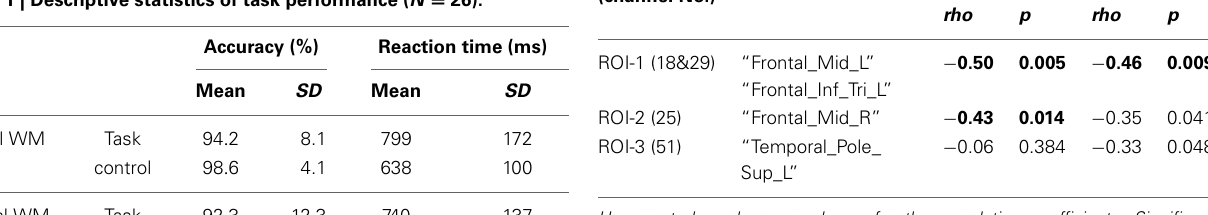
Table 1 | Descriptive statistics of task performance ( N = 26).